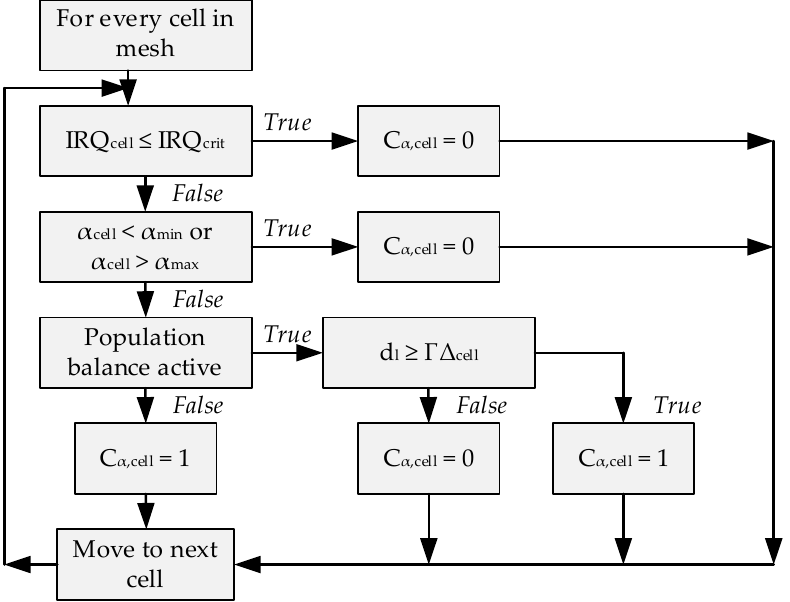
Figure 1. Flow chart showing logic for the switching of the large interface identifier C α . The Interface Resolution Quality (IRQ) index is a numerical indication of interface resolution and is a function of the local mesh size and the local interface curvature, κ . A